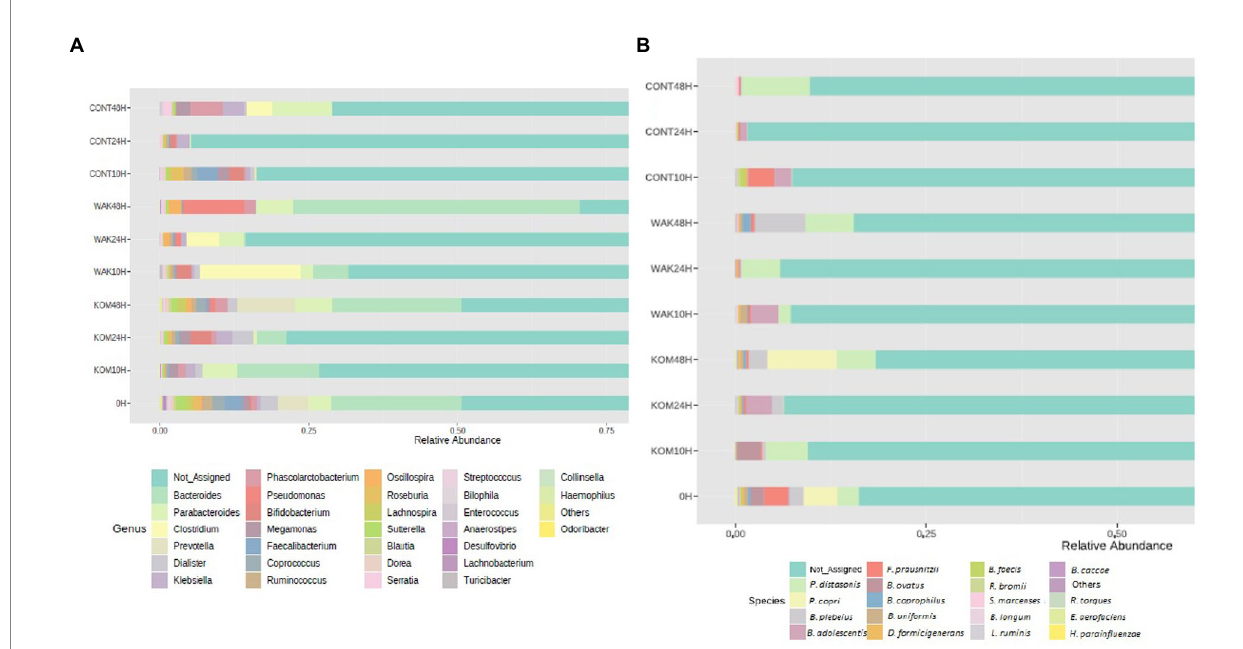
FIGURE 2 Relative abundance of most representative genus and species identified. Bacterial composition (relative abundance, %) determined using 16S rRNA amplicon sequencing at the genus (A) and specie (B) levels. The y axis shows the different substrates evaluated at the different assay times (10, 24, and 48 h). 0 h indicates the bacterial composition before substrate addition. CONT (negative control, without substrate); KOM ( S. japonica , kombu); WAK ( U. pinnatifida ,